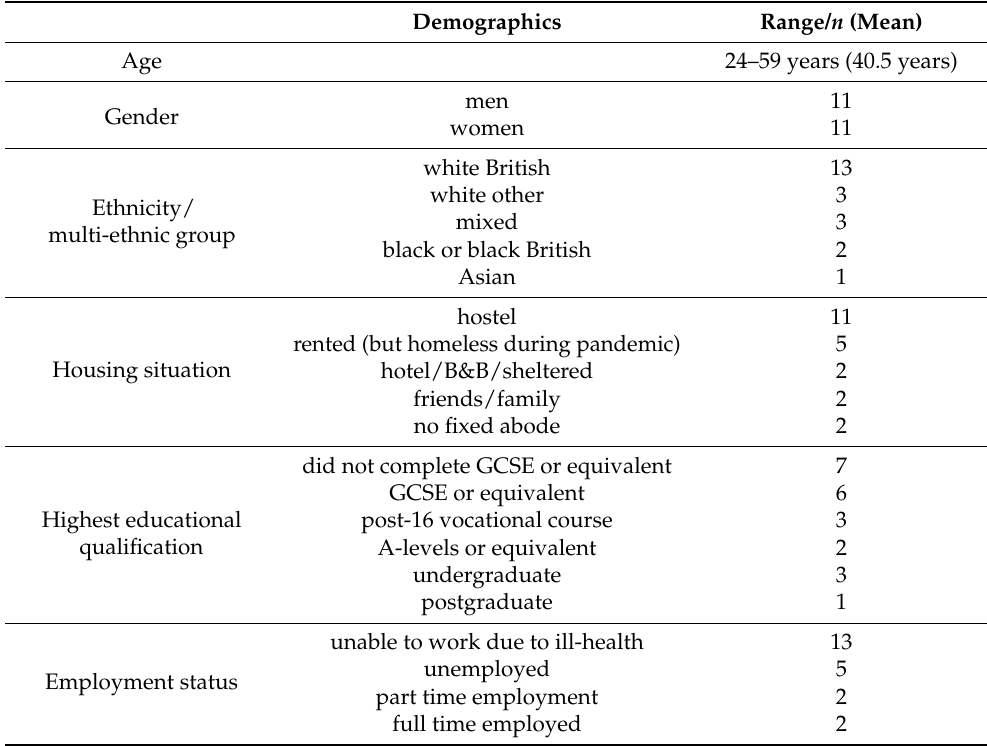
Table 1. Characteristics and demographics of PEH interviewed.